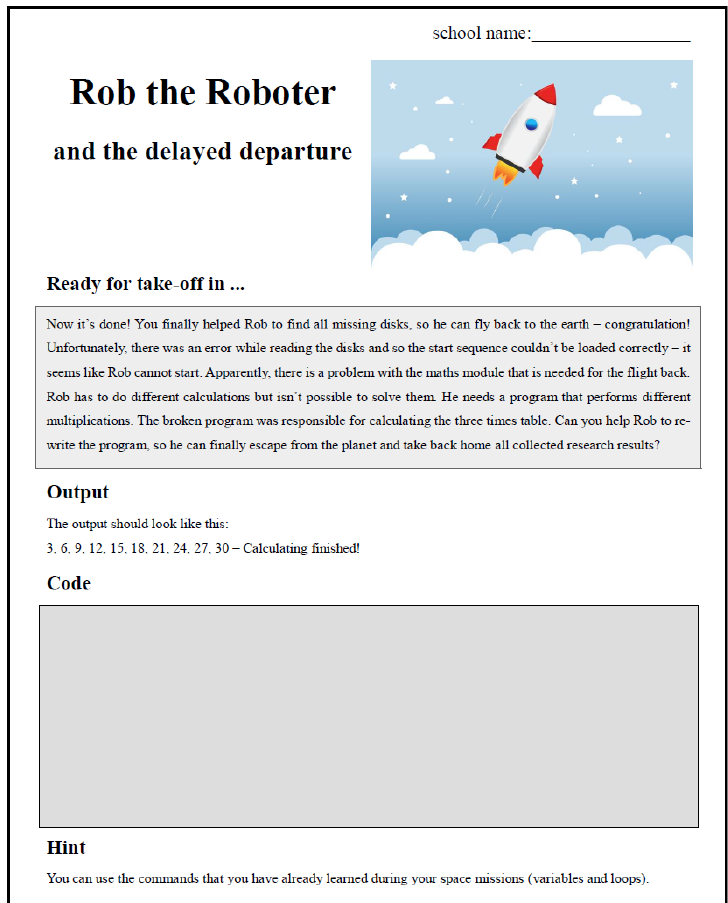
Fig. 4. Worksheet with the final programming